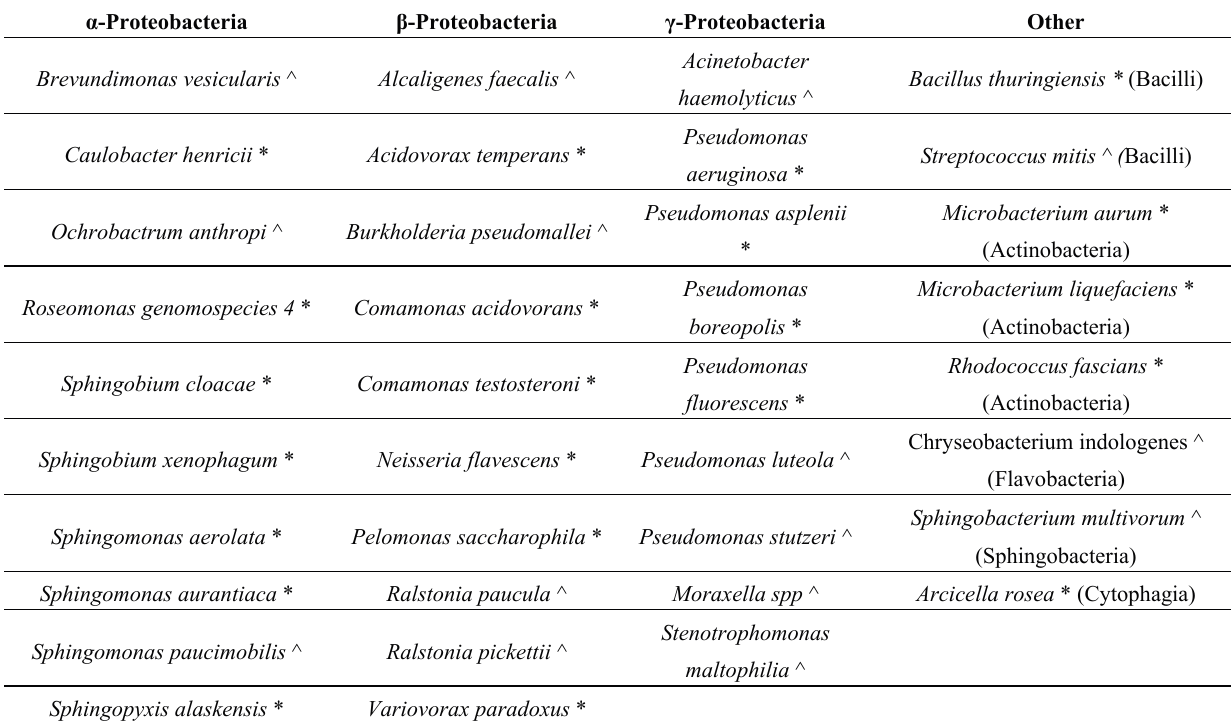
Table 11. Bacteria isolated from aircraft sampling activity A and B, across long-haul, short-haul, and water service vehicle and water